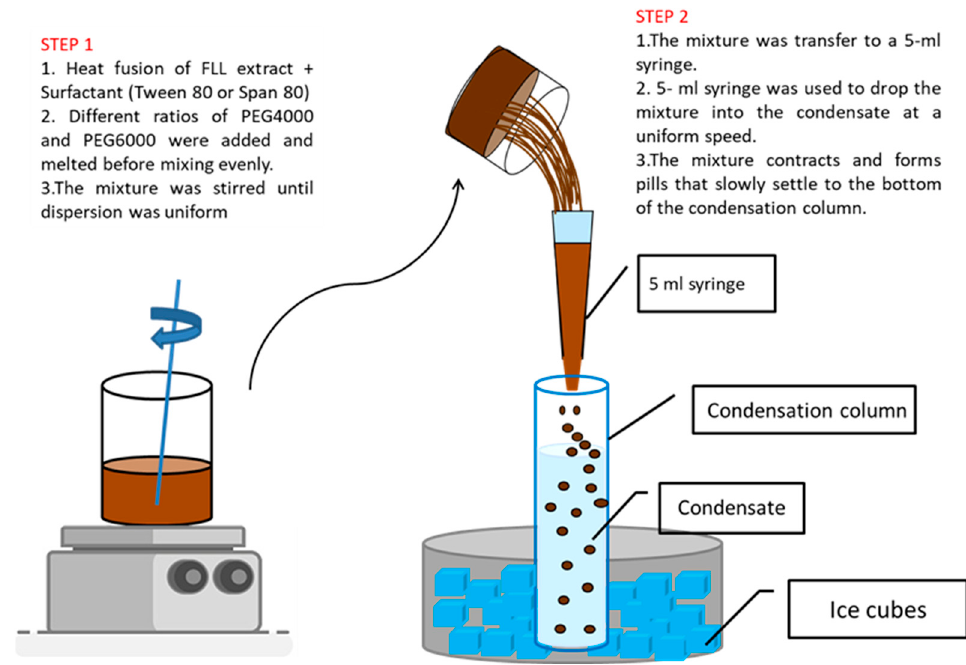
Figure 13. Schematic diagram of FLL dropping pill preparation .